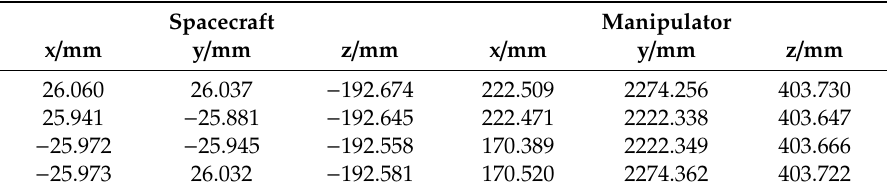
Table 1. Part of the raw measurement data.